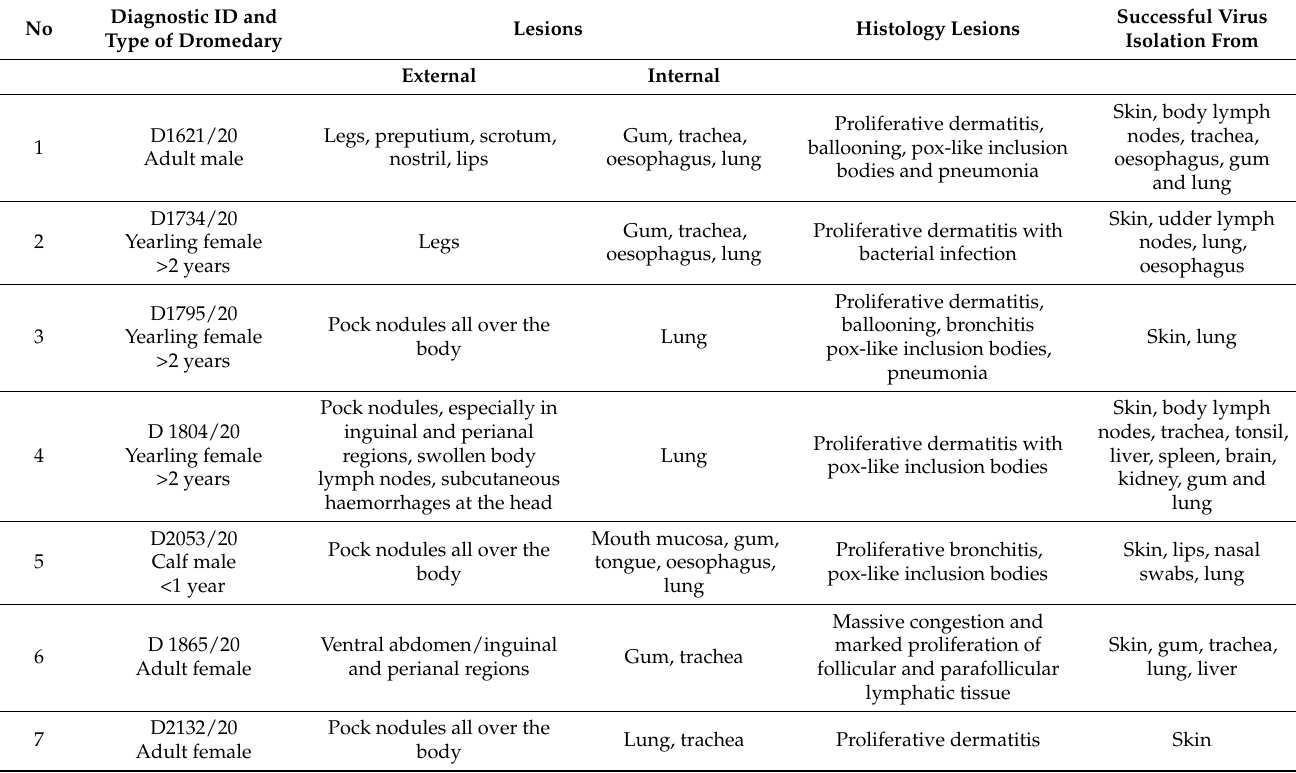
Table 3. Gross pathological and histopathological as well as virus isolation details of camelpox virus infection in a dromedary camel herd. Diagnostic ID and No Type of